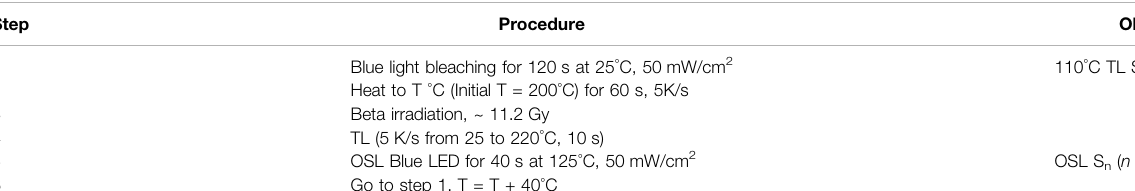
TABLE 2 | Protocol for measurements of thermal activation curves (TAC).